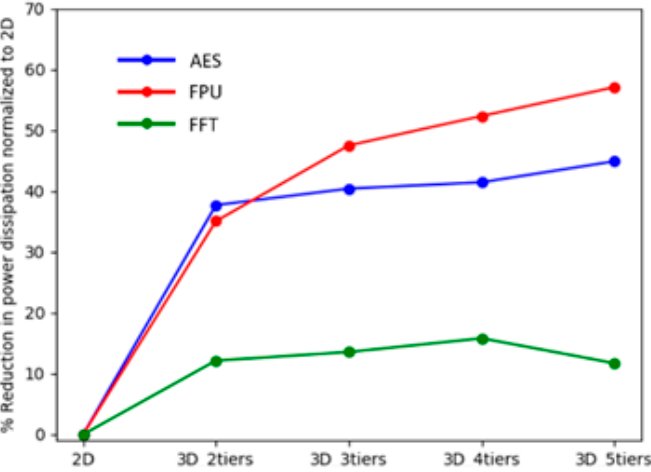
Figure 11. Power dissipation advantage for different tiers.